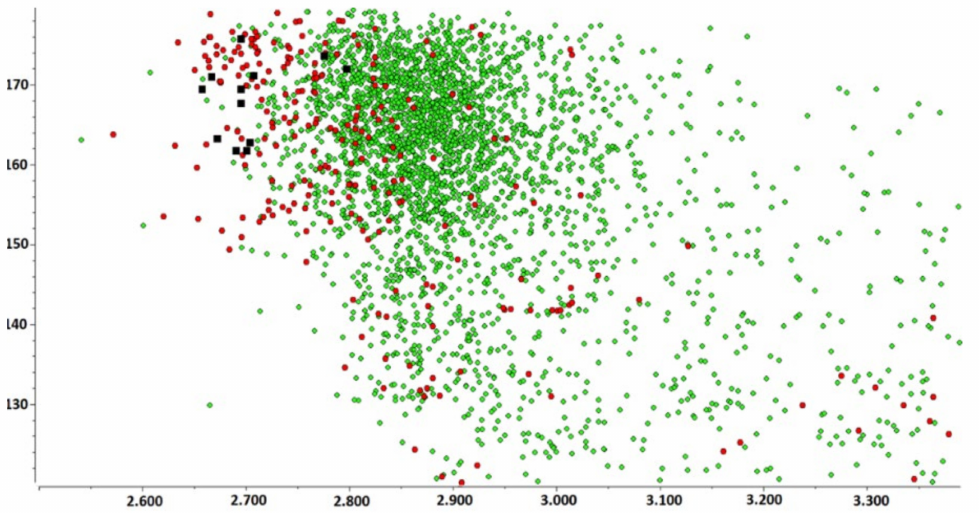
Figure 7. Bond distance vs. bond angle in 2129 neutral NH ··· N (green dots) and 211 charge-assisted NH + ··· N (red spots) hydrogen bonds in azoles. Black squares represent the NH + ··· N supramolecular heterosynthons reported herein.